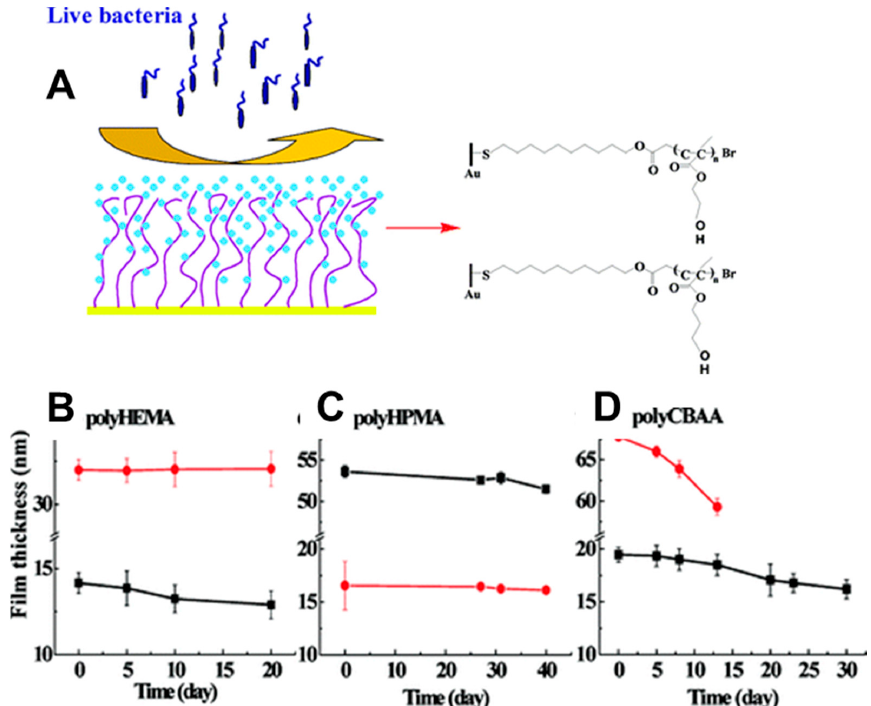
Figure 6. ( A ) Non-fouling biomaterial from gold substrate-initiated atom transfer radical polymerization (ATRP). Change of polymer film thickness of polyHEMA ( B ), polyHPMA ( C ), and polyCBAA ( D ) on surface plasmon resonance (SPR) chips as a function of incubation time in PBS solution (pH 7.4, 0.15 M, 138 mM NaCl, 2.7 mM KCl) for stability test [195]. Reproduced from Zhao